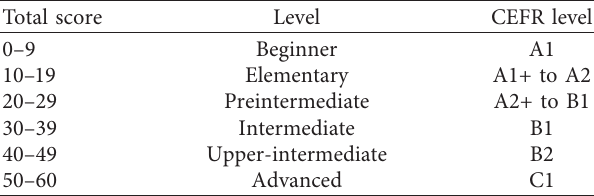
Table 1: Conversion table of